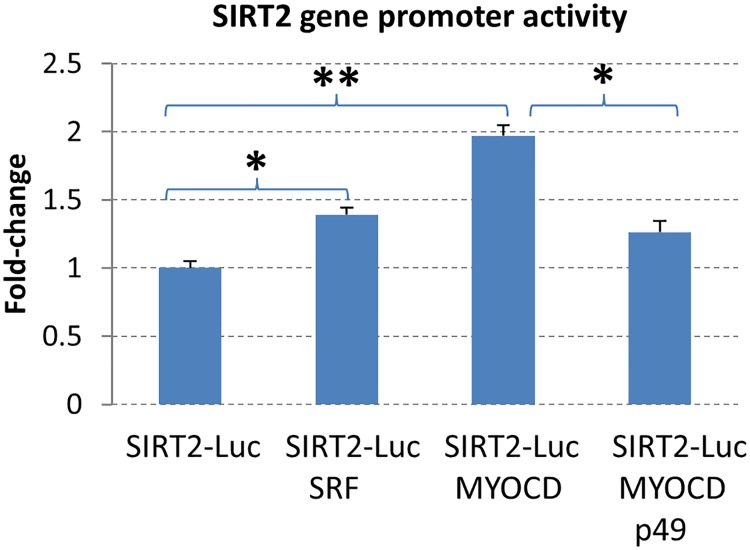
SRF and SRF-binding proteins regulate SIRT2 gene promoter activity.SRF upregulated the SIRT2 gene promoter activity by 1.39 fold + 0.051 (p< 0.05*, n = 3); SRF and myocardin synergistically activated SIRT2 gene promoter activity by 1.97 fold + 0.079 (p< 0.01**, n = 3); while p49/STRAP repressed the SIRT2 promoter activity (1.26 fold + 0.053, p< 0.05*, n = 3) that was induced by myocardin.